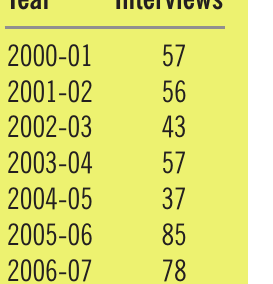
Table 1. Number of interviews analyzed by interview